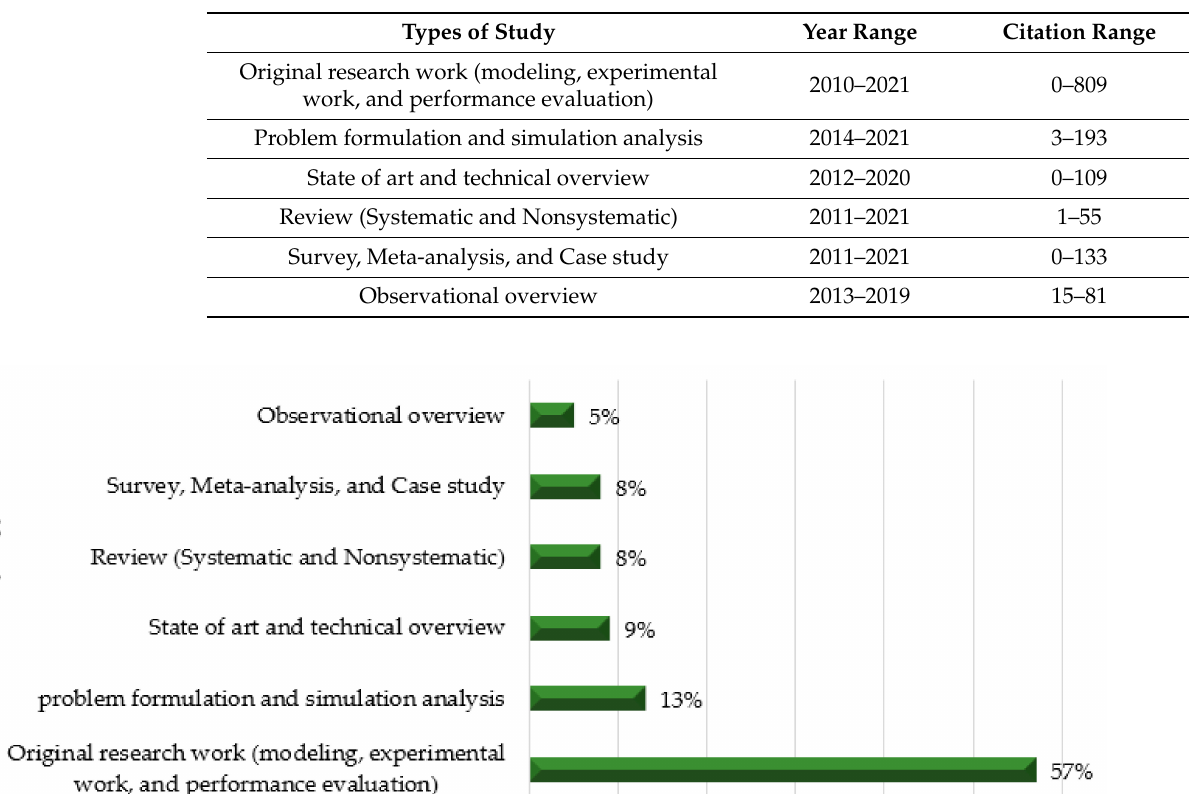
Table 9. Research types and citation range of the most relevant 100 publications based on the Scopus database.